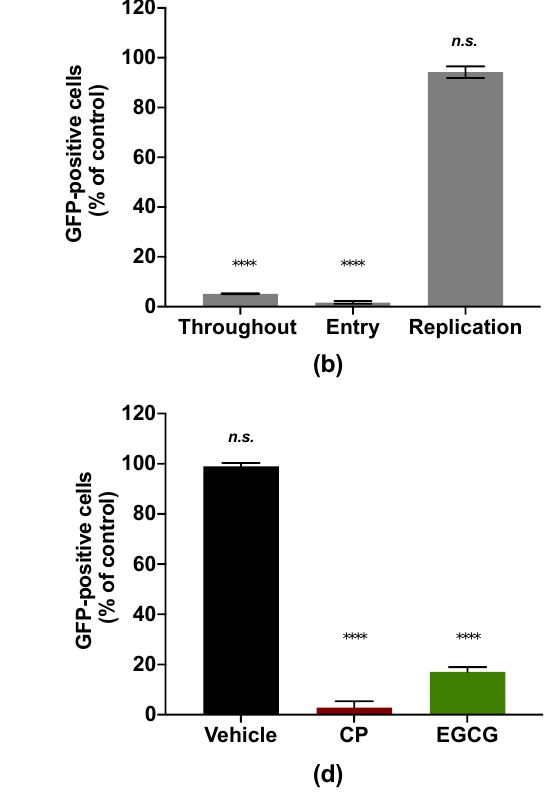
Figure 4. Cranberry pomace extract inhibits the attachment of ZIKV to the surface of A549 cells. ( a ) Schematic illustration of drug addition time assays applied to describe the antiviral activity of CP extract (100 µg/mL). A549 cells were infected and treated with CP extract or vehicle throughout infection (Throughout), simultaneously with virus entry (Entry), after virus challenge (Replication) with appropriate time-wash steps and incubation periods. ( b ) Flow cytometric analysis of infected cells under the different experimental conditions shown in ( a ). ( c ) Schematic illustration of the binding assay. Pre-chilled ZIKV GFP was mixed with CP extract (100 µg/mL) and left to bind to the A549 cell monolayer at 4 °C for 1 h, then moved to 37 °C. EGCG (100 µM) was used as a positive control. ( d ) Flow cytometric analysis of cells infected with ZIKV GFP -A549 in the binding assay shown in ( c ). The results are means ±SD of three independent experiments and are expressed as relative values to vehicle infected cells. One-way ANOVA and Dunnett ’ s test were used for statistical analysis (**** p < 0.0001; n.s. = not significant).